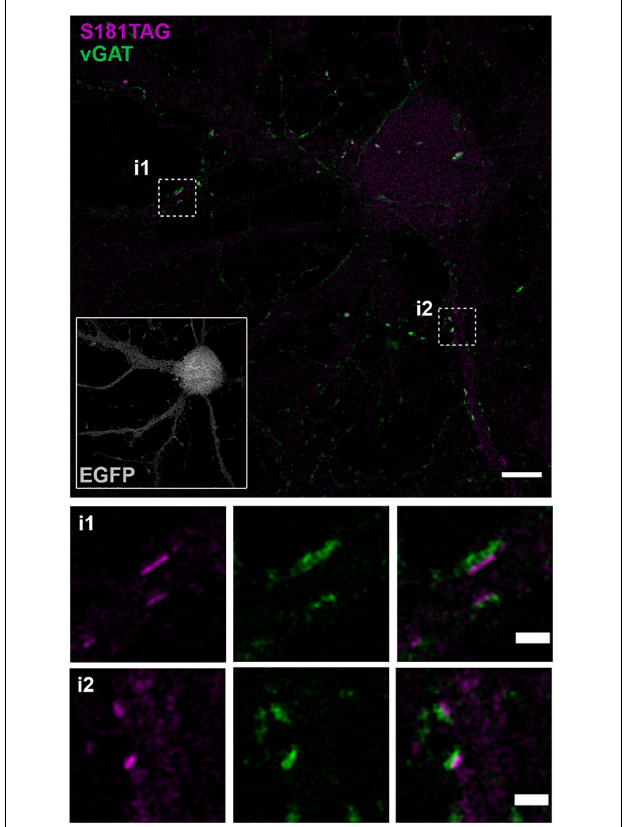
FIGURE 5 | Structured illumination microscopy (SIM) of clickable GABA-A receptor α 2 subunits transfected in primary neurons (DIV 14) by effectene. SIM image depicting neuronal morphology by co-expression of cytosolic EGFP (gray, inset, lower left). Postsynaptic S181TAG α 2 subunits clicked by Pyrimidyl-tet-ATTO643 (magenta) and immunolabeling of GABAergic presynapses by primary vGAT antibody and goat anti-mouse AF568 secondary antibody (green). Insets provide higher detail images of localization of S181TAG α 2 subunits next to presynaptic compartments of GABAergic synapses. Scale bar: 5 µ m (overview image), 1 µ m (zoomed